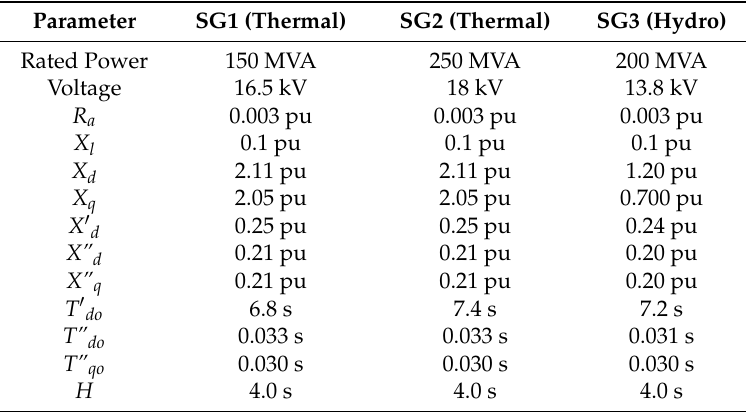
Table 2. Parameters of synchronous generators (SGs).